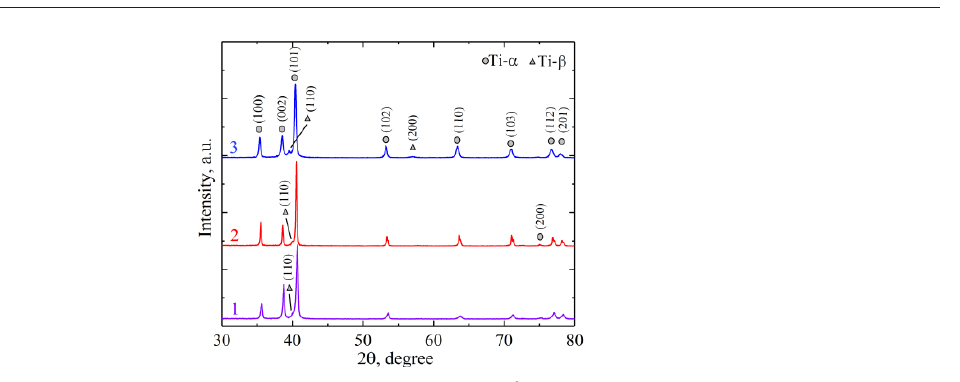
Fig. 2. XRD patterns of the SLM-(1), EBM-(2) and EBF 3 -produced Ti–6Al–4V samples (3).